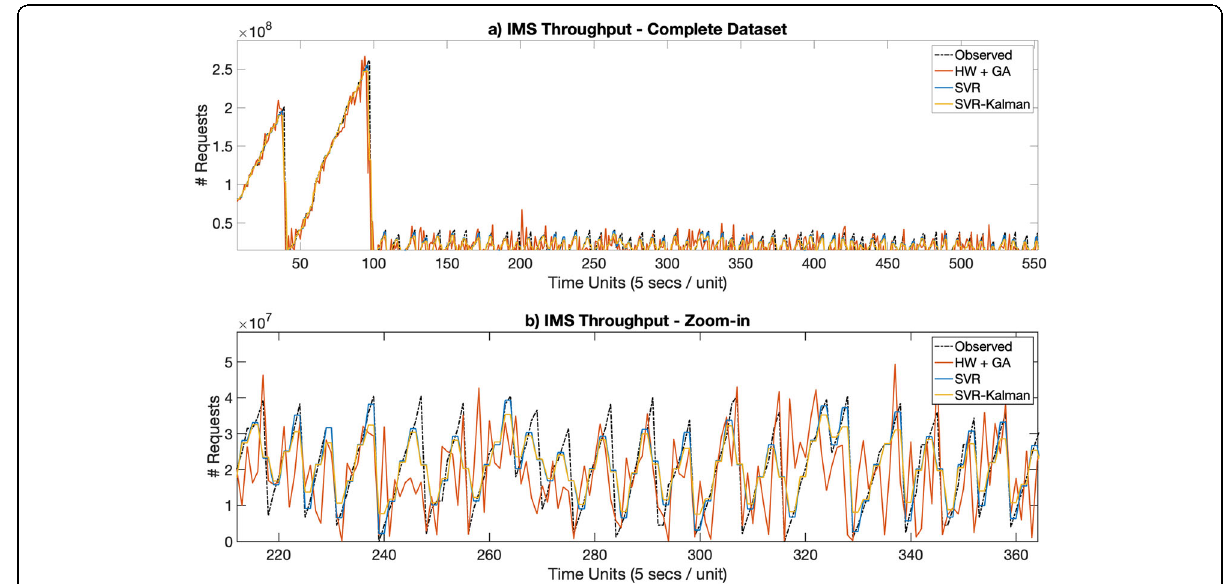
Fig. 7 IMS Throughput Observed and Estimated data: a Complete dataset, b